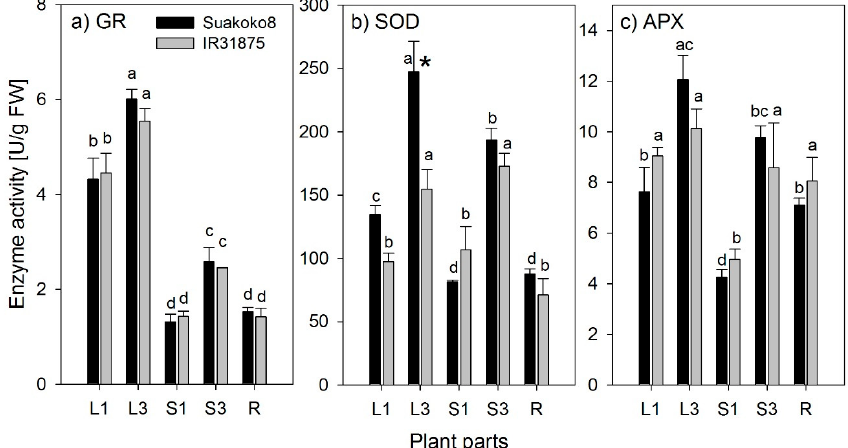
Figure 1. Enzyme activity of ( a ) glutathione reductase (GR), ( b ) superoxide dismutase (SOD), and ( c ) ascorbate peroxidase (APX), measured fresh for 2 varieties, Suakoko8, black, and IR31785, grey, L1 = the leaf blade and S1 = the sheath of the youngest fully developed leaf of the main culm; L3 and S3 = the blade and sheath of the third youngest fully developed leaf of the main culm; R = root. Error bars = standard error of mean (n = 3), asterisk depicts significant di ff erences between varieties, di ff erent letters show significant di ff erences between plant parts within the same variety (LSD test, p <